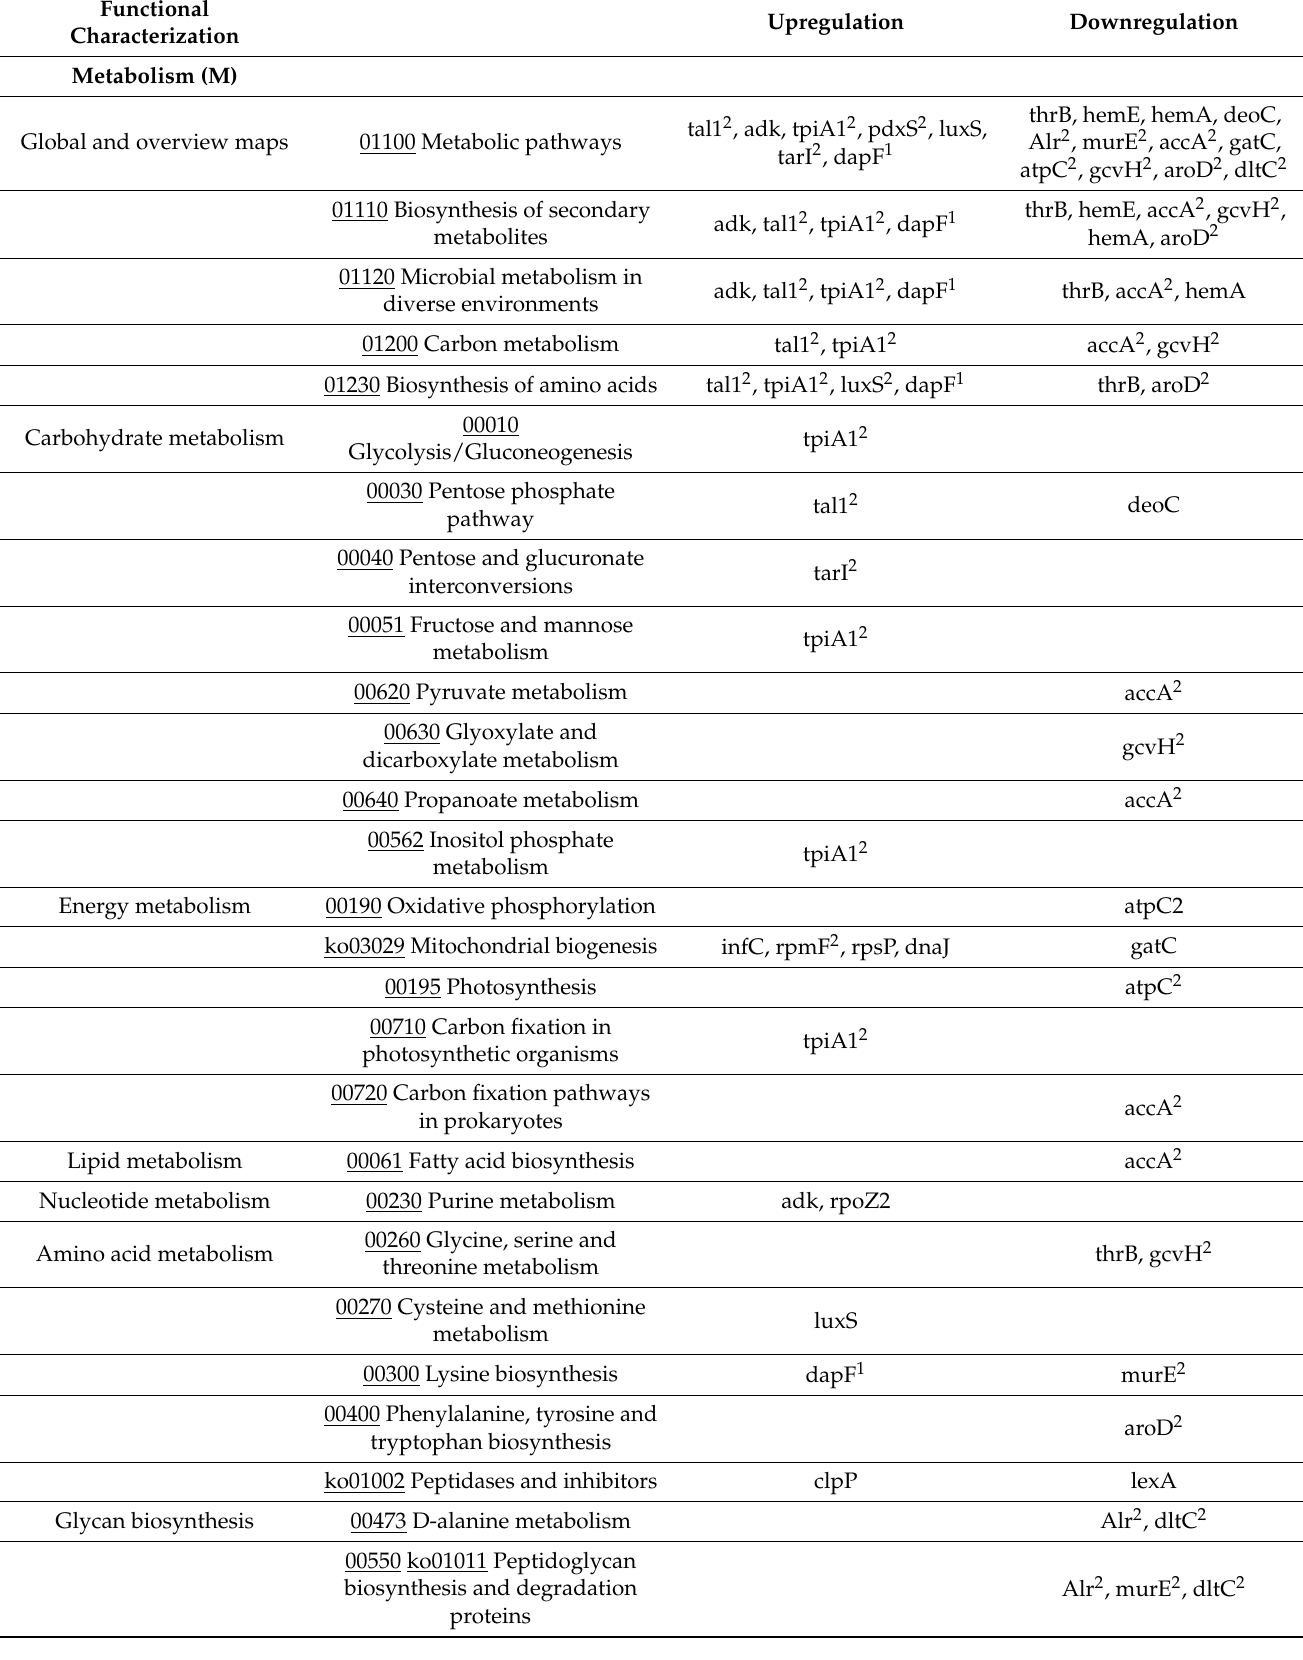
Table 1. KEGG pathway analysis of the DEPs of L. monocytogenes under HPP at 200 and 400